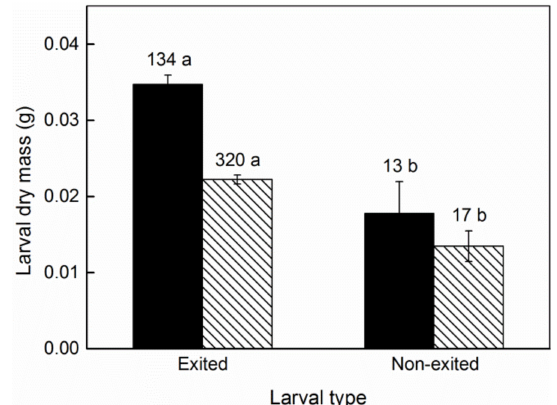
Figure 4. Difference in larval dry mass (mean ± SE , g) between exited and non-exited larvae. Black bars, C . oleifera ; lined bars, C . meiocarpa . Values above the error bars indicate sample sizes. Different letters indicate significant differences in larval dry mass ( t test, p < 0.05).